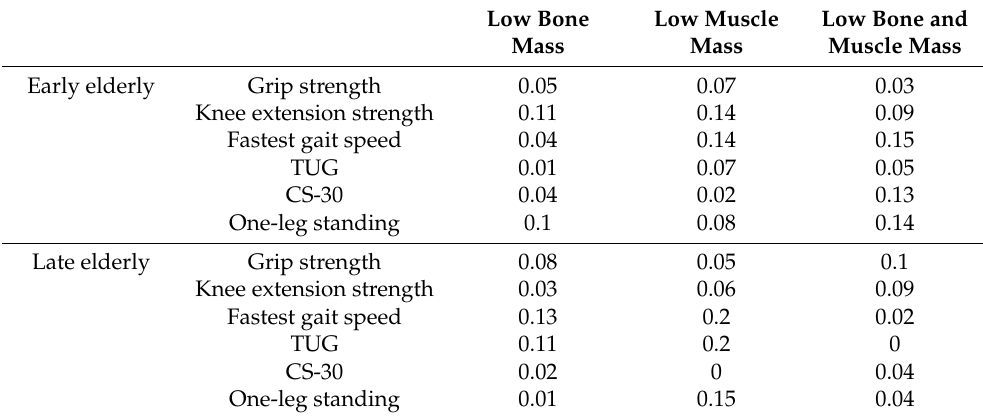
Table 5. Effect sizes of the differences between the healthy group and the other groups in the early and late elderly